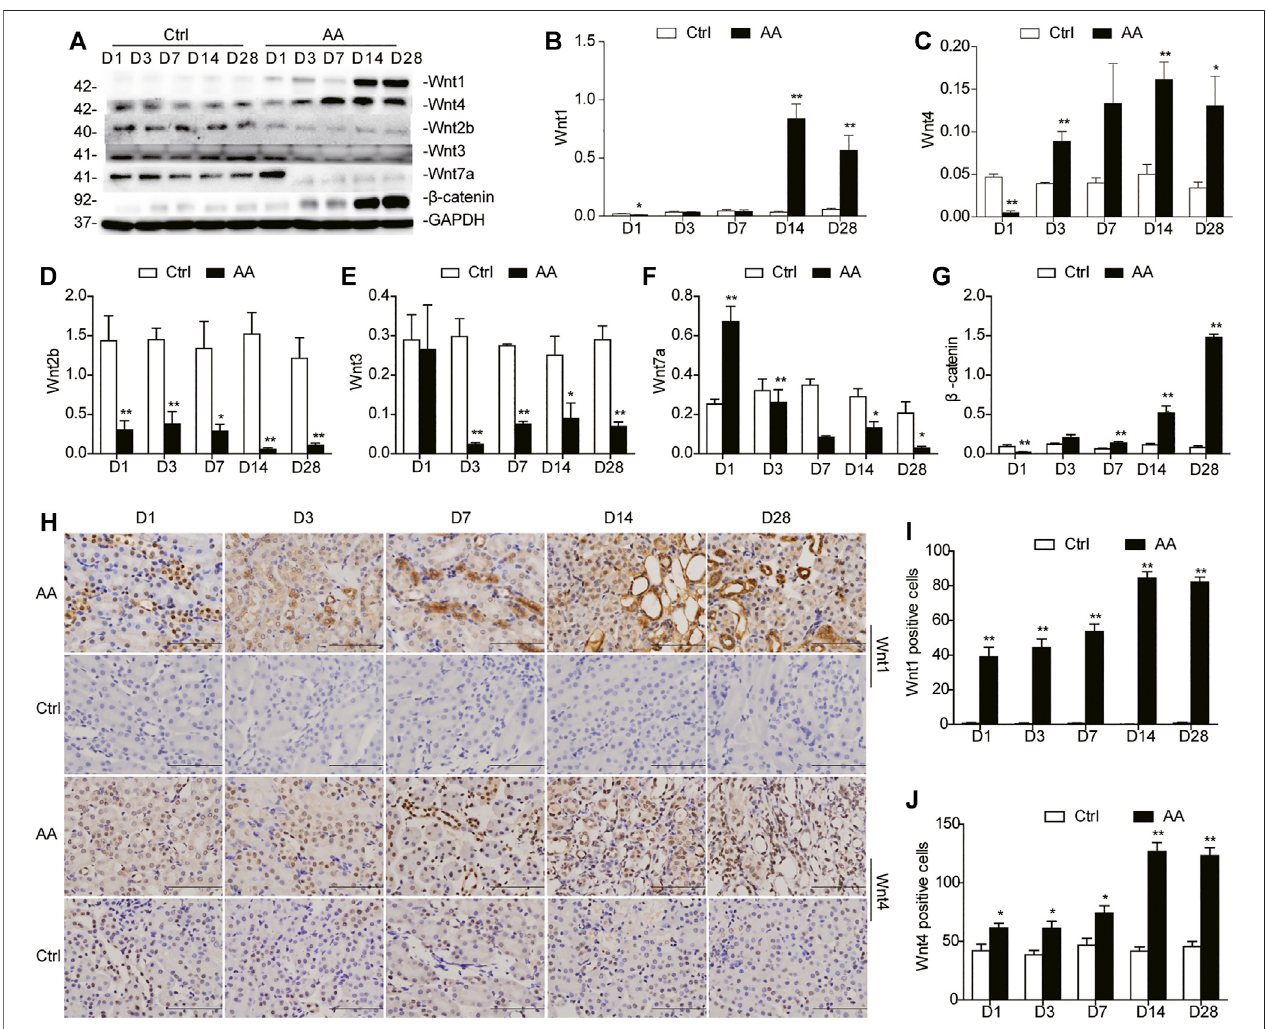
FIGURE2| SustainedWnt/ β -cateninpathway activationsecondarytoAAinducesAKI. (A) WesternblotofrepresentativeWntligands(Wnt1,Wnt2b,Wnt3,Wnt4, Wnt7a) and β -catenin in mouse kidney tissues. Mice were sacri fi ced on days 1, 3, 7, 14, or 28 after AA administration. (B – G) Quantitative western blot data. (H) ImmunohistochemicalstainingofWnt1andWnt4inthekidneys(magni fi cation,400 × ,bar (cid:2) 200 μ m). (I,J) ThenumberofWnt1/Wnt4positivecellsinthemousekidneys. Each mouse was calculated for quanti fi cation of 10 high-power fi elds. * p < 0.05 and ** p < 0.01 vs. control groups (Ctrl), n (cid:2) 6.